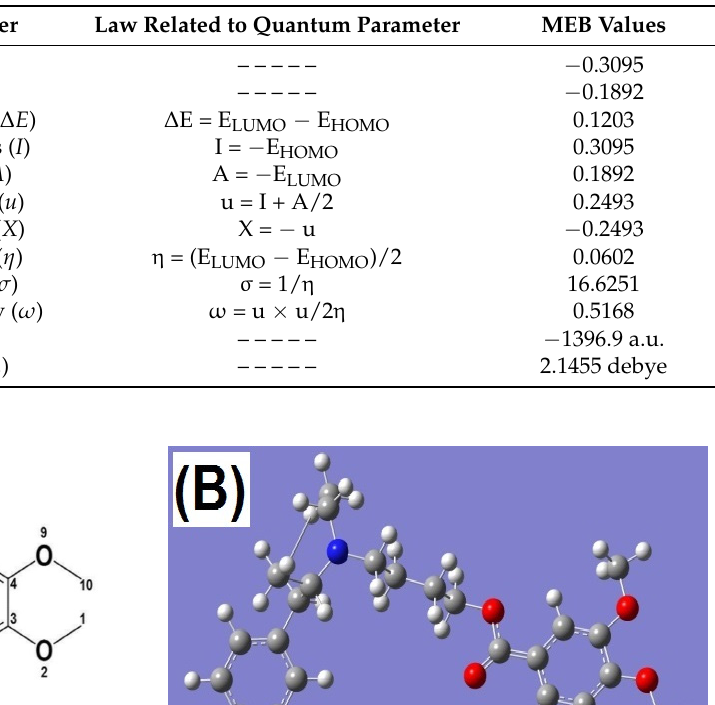
Table 1. Calculated quantum chemical parameters of MEB.